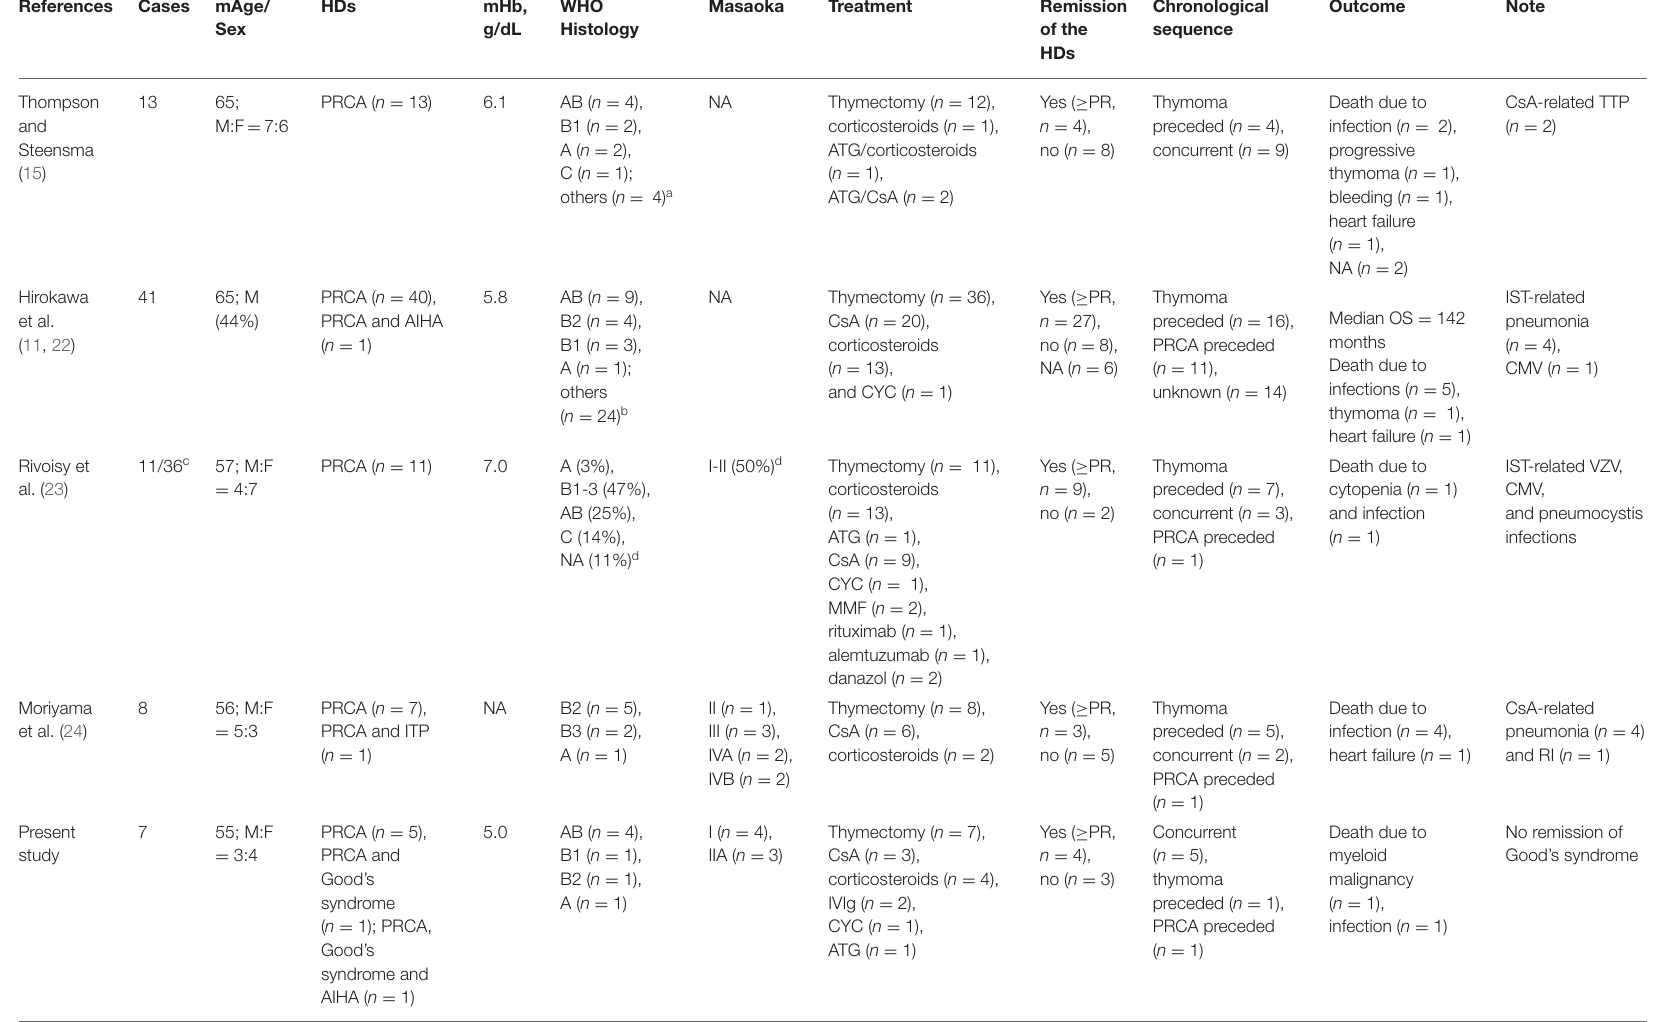
TABLE 4 | Comparison of the present study with the